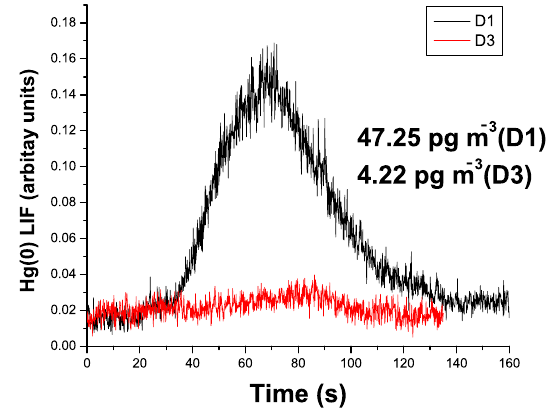
Figure 11. KCl manual denuder measurements from 16 September. The calibrated TDPs for the tandem denuder pair, D1 and D3, are